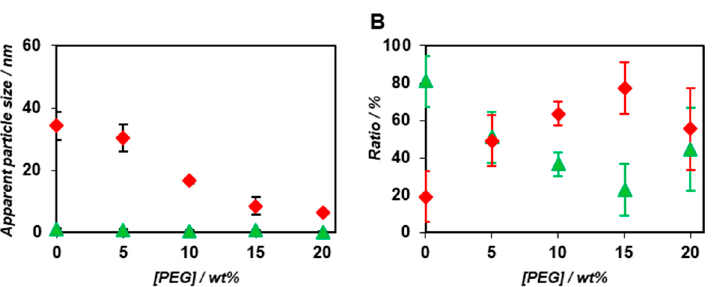
Figure 5. Effect of PEG 2000 on the apparent diameter ( A ) and ratio ( B ) of the fast (green) and slow components (red) determined by FCS curve fitting ( N = 3) in the presence of PEG 2000 at constant concentrations of the BODIPY- β -annulus (0.1 μ M) and β -annulus peptides (25 μ M) at 25 °C.